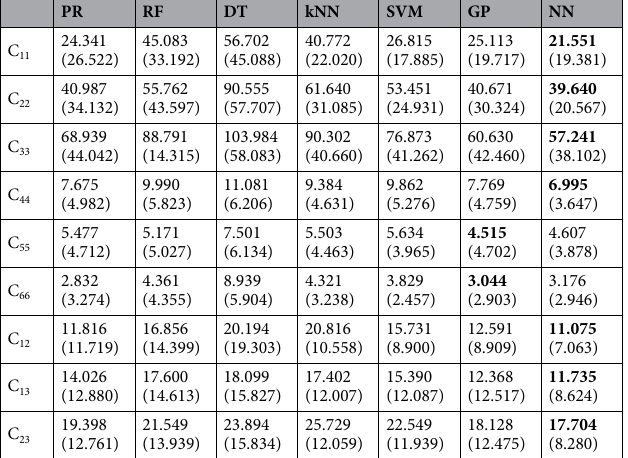
Table 1. Comparison of mean squared error (MSE) values provided by ML algorithms for the training (value inside the parentheses) and test set.